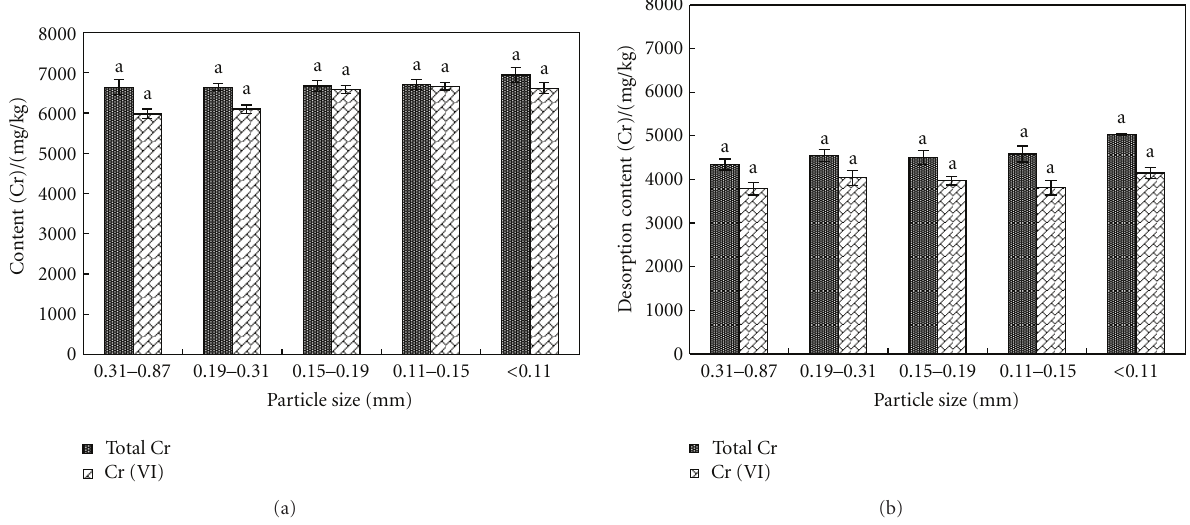
Figure 1: Contents and desorption contents of total Cr and Cr (VI) in 5 samples of di ff erent sizes.